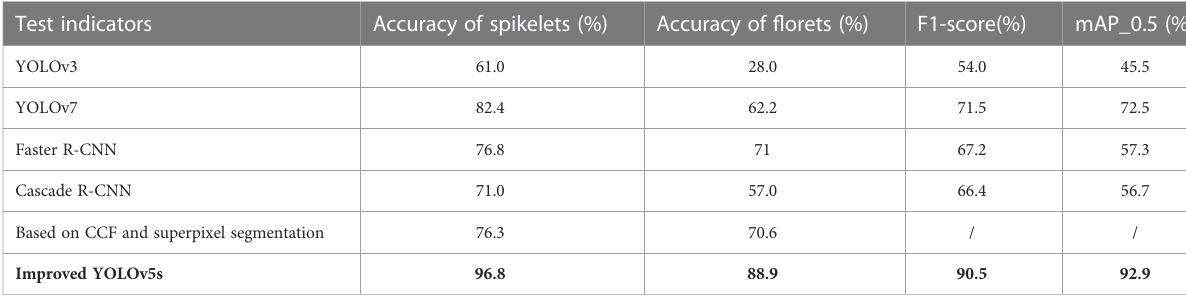
TABLE 4 Indicators results of the six models on the test set.